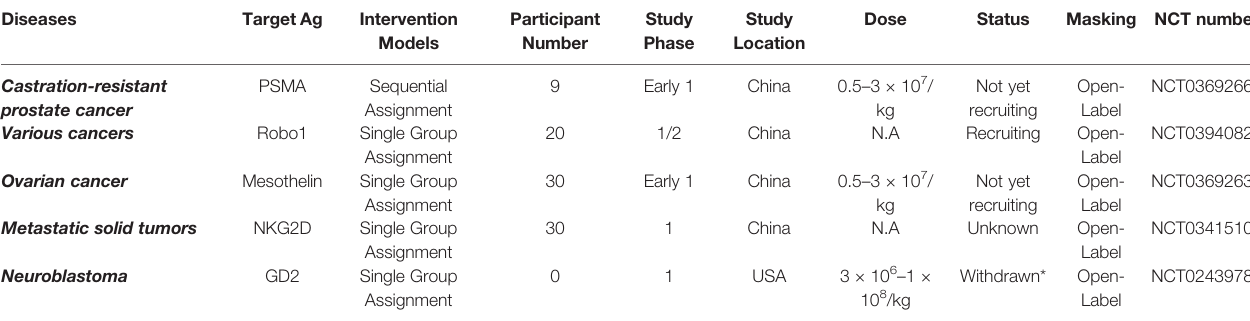
TABLE 3 | A brief overview of clinical trials in the context of the CAR NK cell-based therapy for human solid tumors registered in ClinicalTrails.gov (March 2021).